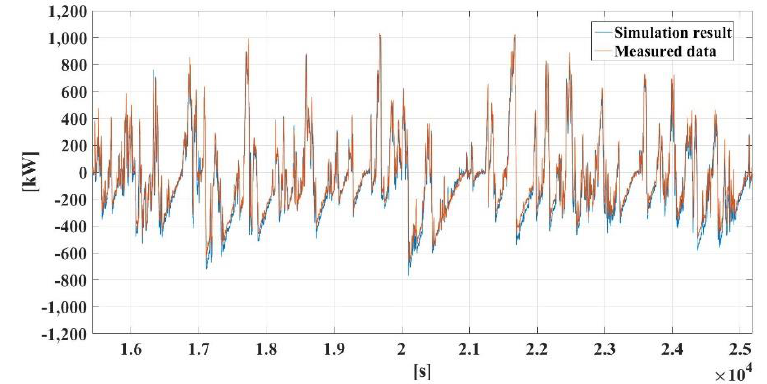
Figure 23. Field test and simulation results: output powers of ESS (zoomed segment 1).